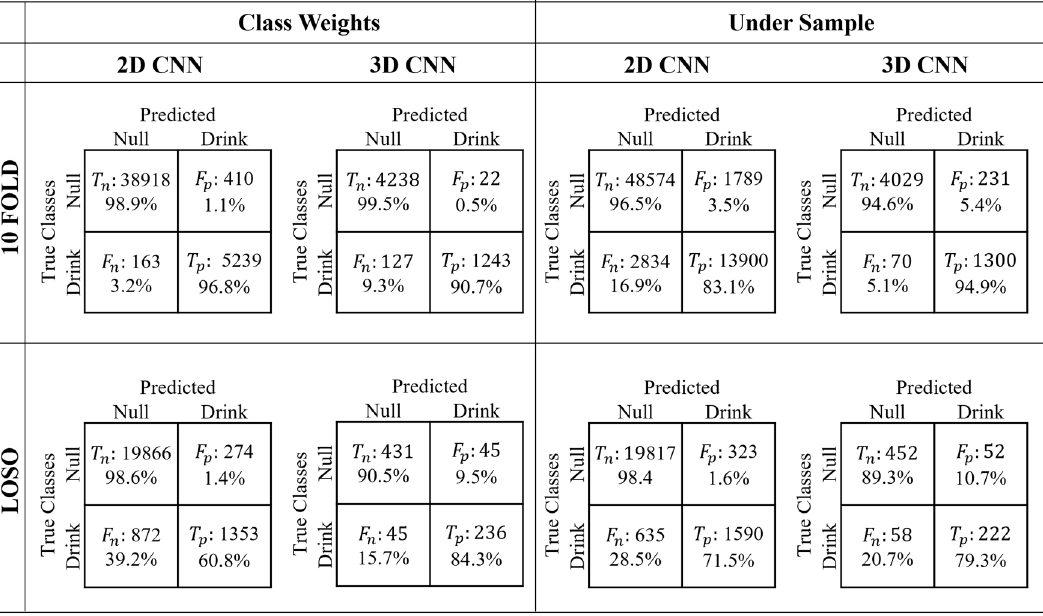
Figure 5. Confusion matrices from the 10-fold and LOSO validation, trained by using class weights and under-sampling for the 3D and 2D classification models. T n , F p , F n , and T p refer to true negative, false positive, false negative and true positive. Table 2. Performance metrics for the best models. The values in the brackets represent the standard deviations for each metric across the folds.